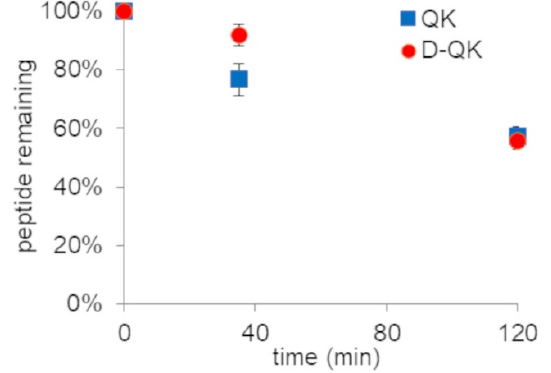
Figure 6 . Analysis of peptide stability in 50% human serum. The relative amount of peptide was determined by RP-HPLC measuring the area of the peptide peak revealed at 220 nm. Data are reported as means of a triplicate experiment.